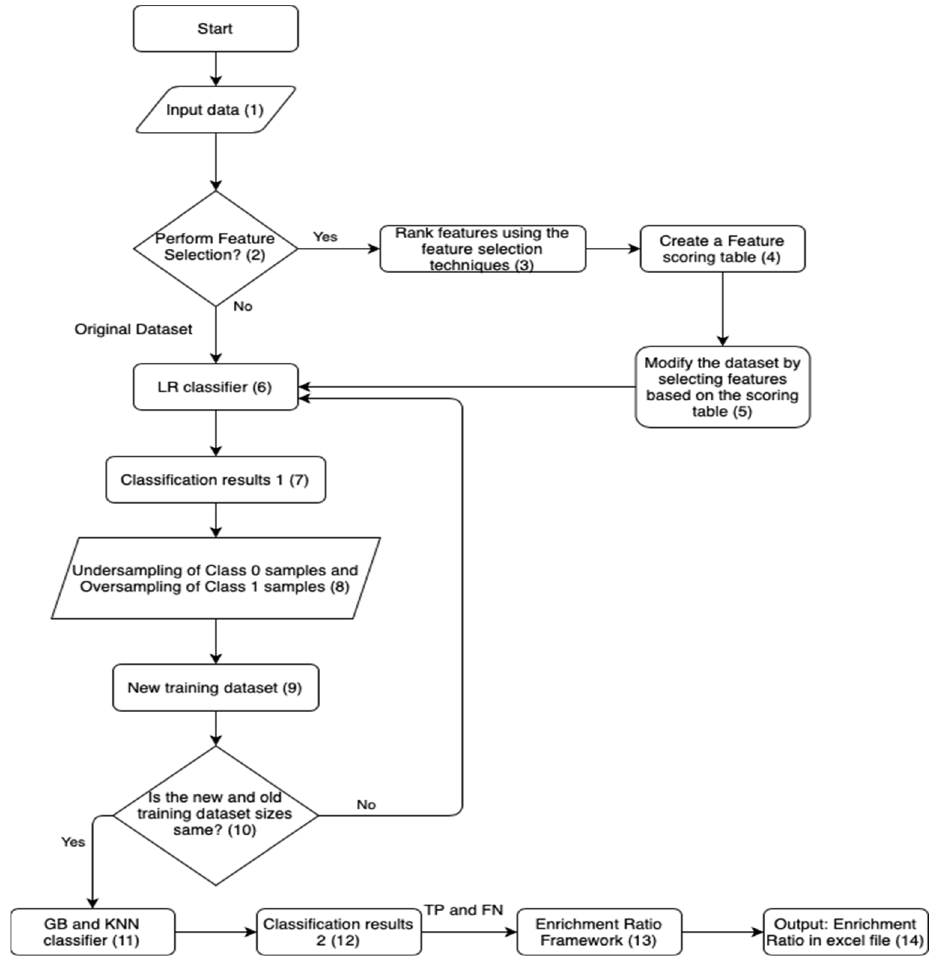
Figure 1. Flowchart of the proposed sampling-based framework with Enrichment ratio.